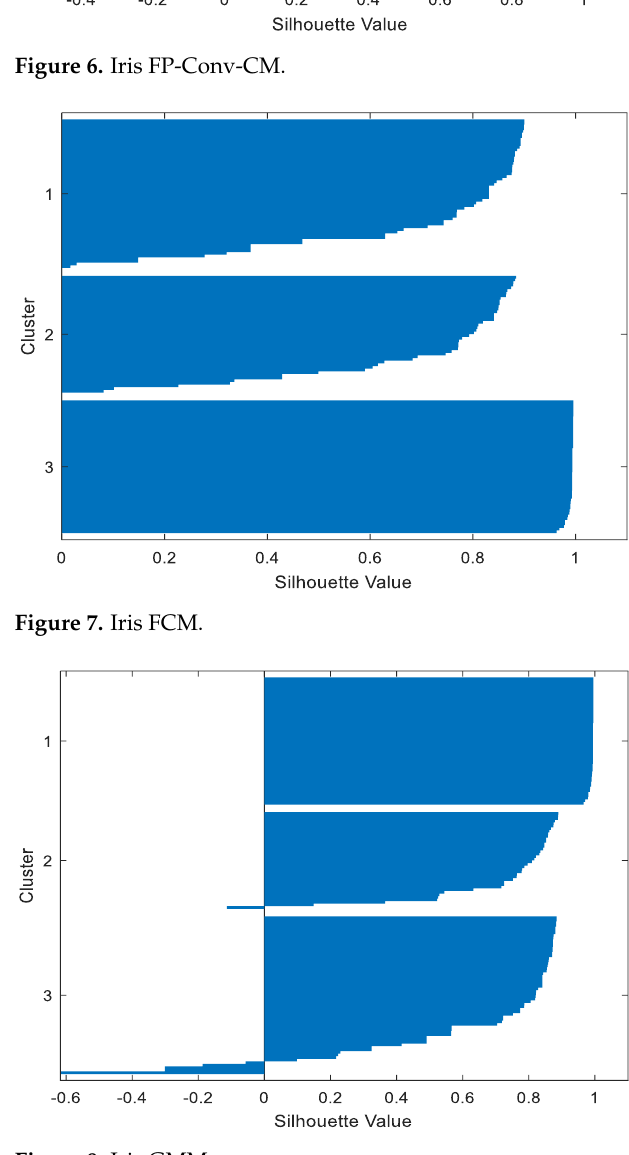
Figure 9. Foods FP-Conv-CM.